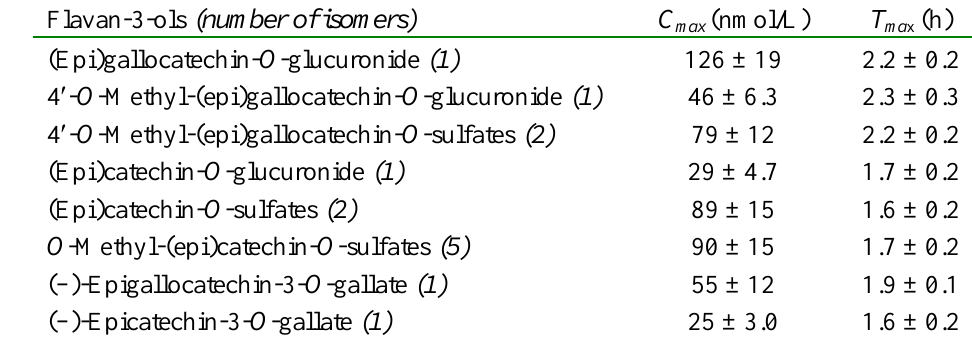
Table 2. Pharmacokinetic analysis of flavan-3-ols and their metabolites detected in plasma of healthy volunteers following the ingestion of 500 mL of green tea. Data expressed as mean values ± SE (n =